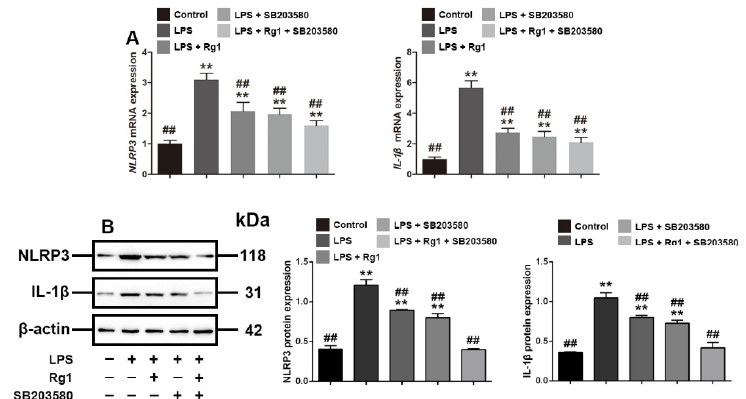
Figure 4. Rg1 regulates NLRP3 and IL-1 β through p38 MAPK signaling in IPEC-J2 cells treated with LPS in vitro. PEC-J2 cells were treated with vehicle, LPS (2 μ g/mL), SB203580 (10 μ M), and Rg1 (60 μ M) for 48 h. (A) mRNA level analyses of NLRP3 and IL-1 β ; (B) Western blot analyses of NLRP3 and IL-1 β . β -Actin was used as an invariant control for equal loading. Blots are representative of three independent experiments with densitometry showing the mean ± s.d. * p < 0.05 versus control and ** p < 0.01 versus control. # p < 0.05 versus LPS and ## p < 0.01 versus LPS.